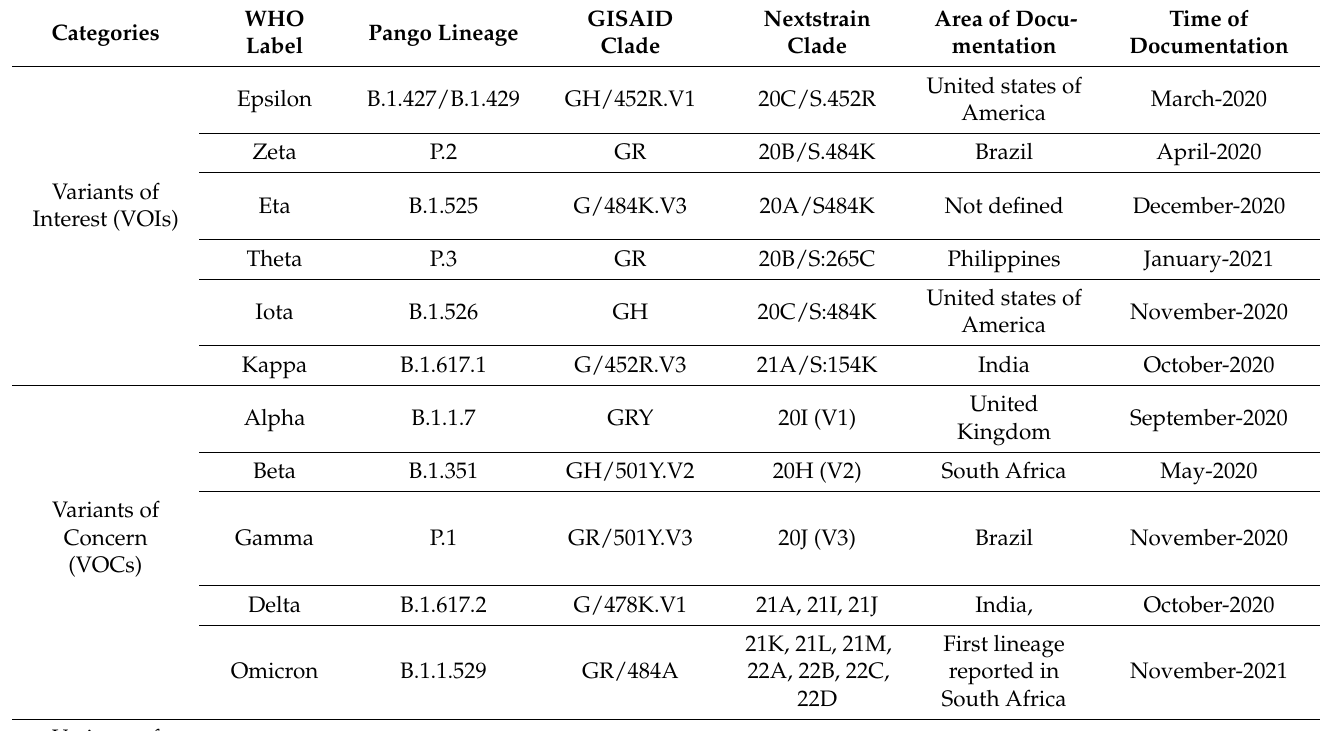
Table 1. Showing the various categories of the variants of SARS-CoV-2 with their clades and origin